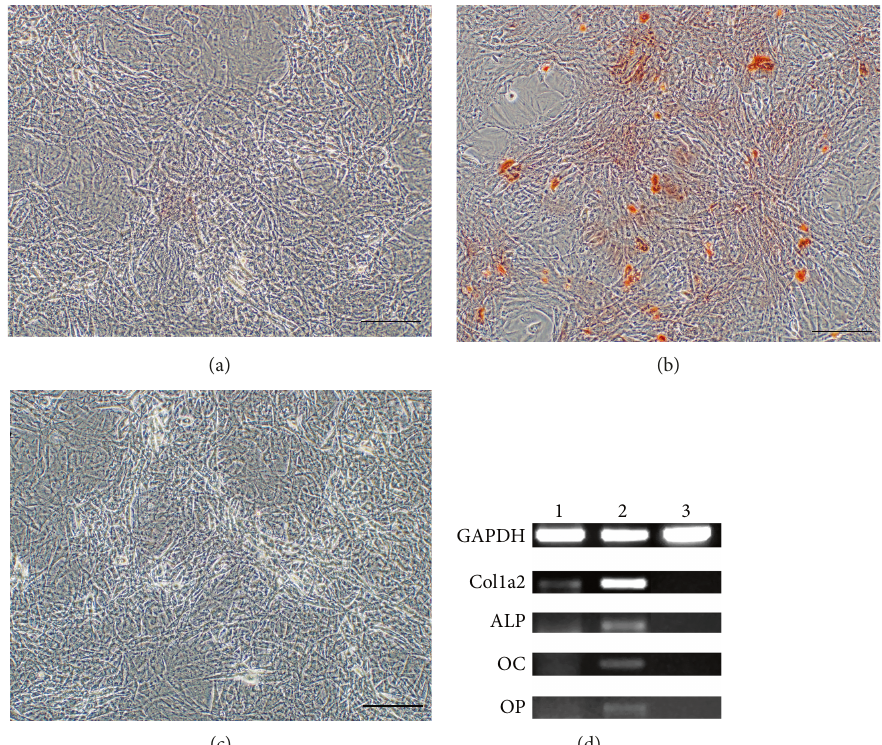
Figure 2: Analyses of the MSC sheets on the basis of Alizarin Red S staining and reverse transcription polymerase chain reaction (RT-PCR). Mineralization of MSC sheets was analyzed on the basis of Alizarin Red S staining in all groups. Osteogenic gene expression pro fi les in all groups of MSC sheets were analyzed on the basis of RT-PCR. MSC sheets maintained in osteogenesis-stimulating medium supplemented with the triple cocktail for 21 days stained positive with Alizarin Red S (b) and they exhibited increased levels of collagen type I (Col1a2), osteocalcin (OC), osteopontin (OP), and alkaline phosphatase (ALP) mRNA (d) in comparison to MSC sheets maintained in basal medium supplemented with only ascorbic acid (a, d). MSC sheets maintained in basal medium supplemented with only ascorbic acid showed slight osteogenic di ff erentiation (a, d) when compared to the MSC sheets maintained in basal medium without any supplementation (c, d); however, this di ff erentiation was not as strong as seen in the triple cocktail supplemented group (b, d). Sequences and sources of the primers used for the gene expression analyses were given in Table 1. (d) Lane 1: MSC sheets maintained in basal medium supplemented with only ascorbic acid; lane 2: MSC sheets maintained in osteogenesis-stimulating medium; lane 3: MSC sheets maintained in basal medium without any supplementation; GAPDH: glyceraldehyde 3-phosphate dehydrogenase (housekeeping gene used as loading control in this experiment). Scale bar =200 μ m for (a, b,